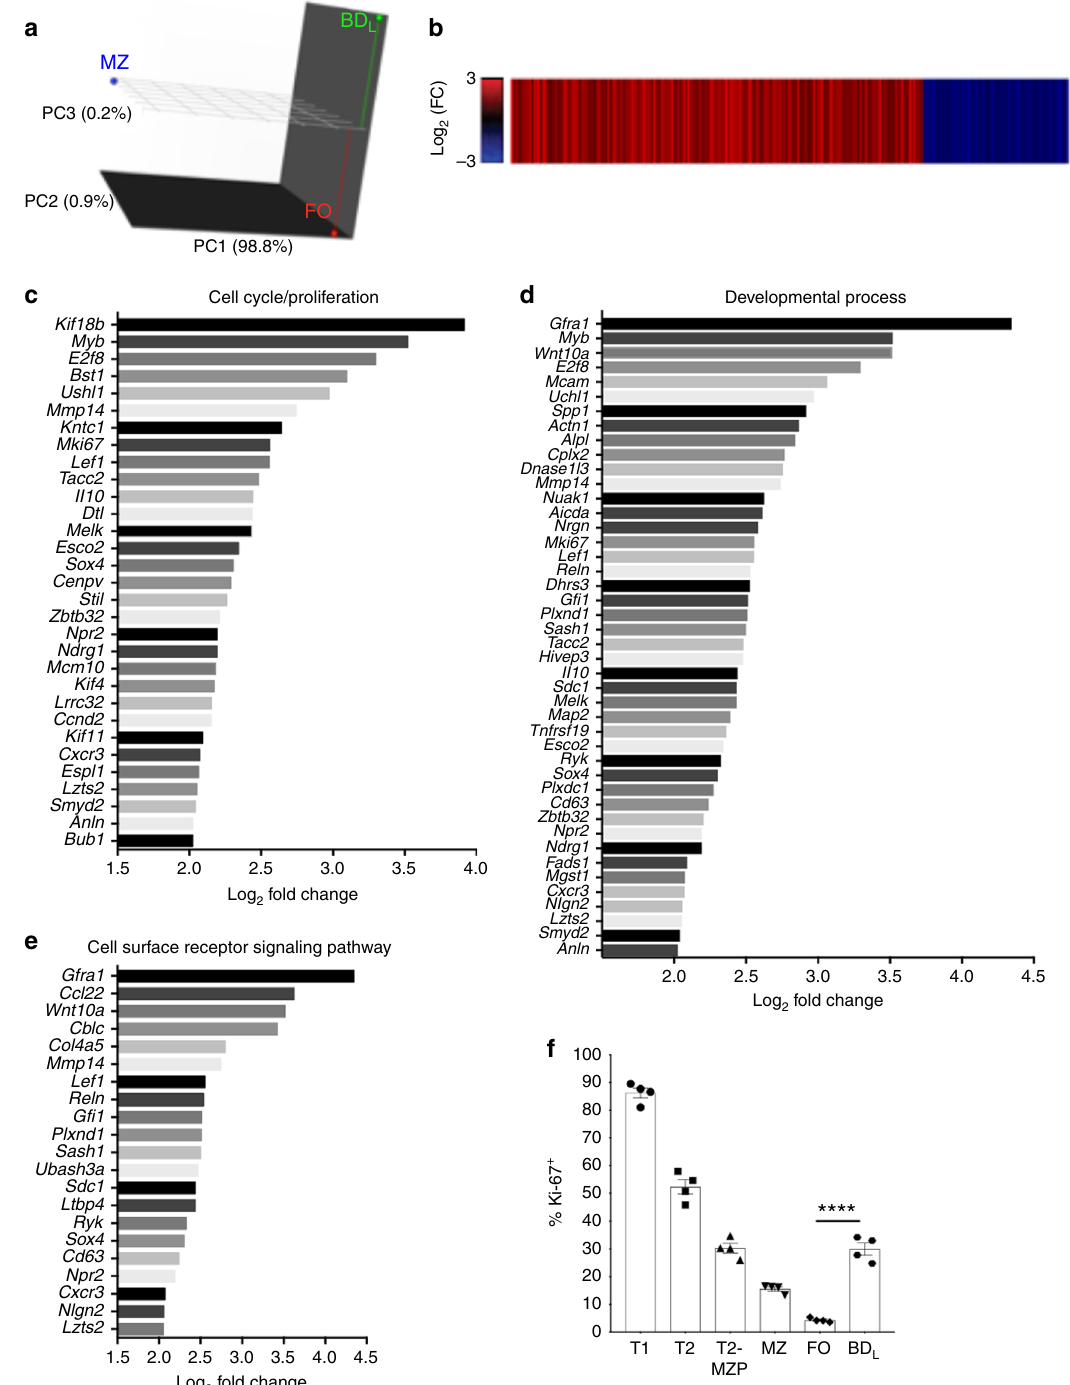
Fig. 4 BD L undergo a high rate of proliferation. RNA-seq analysis was performed on FACS puri fi ed splenic BD L , FO, and MZ B cells from B10.PL mice. a PC analysis was performed on the log 2 -transformed FPKM, with the % variance encompassed within each PC shown. The distribution of BD L (green), FO (red), and MZ (blue) B cells within the 3D plot are shown. b A heat map displaying the log 2 fold change for genes that showed a signi fi cant difference (Benjami – Hochberg adjusted p < 0.05) between BD L and FO B cells are shown. Red bars show genes more highly expressed and blue reduced expression in BD L . n = 3. c – e Barplots of the most highly differentially expressed genes (log 2 fold change >2) in BD L compared to FO cells within the select Gene Ontology terms cell cycle/proliferation ( c ), developmental process ( d ), and cell surface signaling pathway ( e ) are shown. f The percentage of splenic T1 (B220 + IgM hi CD21 low CD23 − CD93 + ), T2, T2-MZP (B220 + IgM hi CD21 hi CD23 + ), MZ, BD L and FO B cells from C57BL/6J mice expressing Ki-67 was determined by fl ow cytometry. f Individual data points (mice) are shown superimposed upon the mean ± SEM from one independent experiment of two. **** p < 0.0001. Statistical signi fi cance was determined using the unpaired t